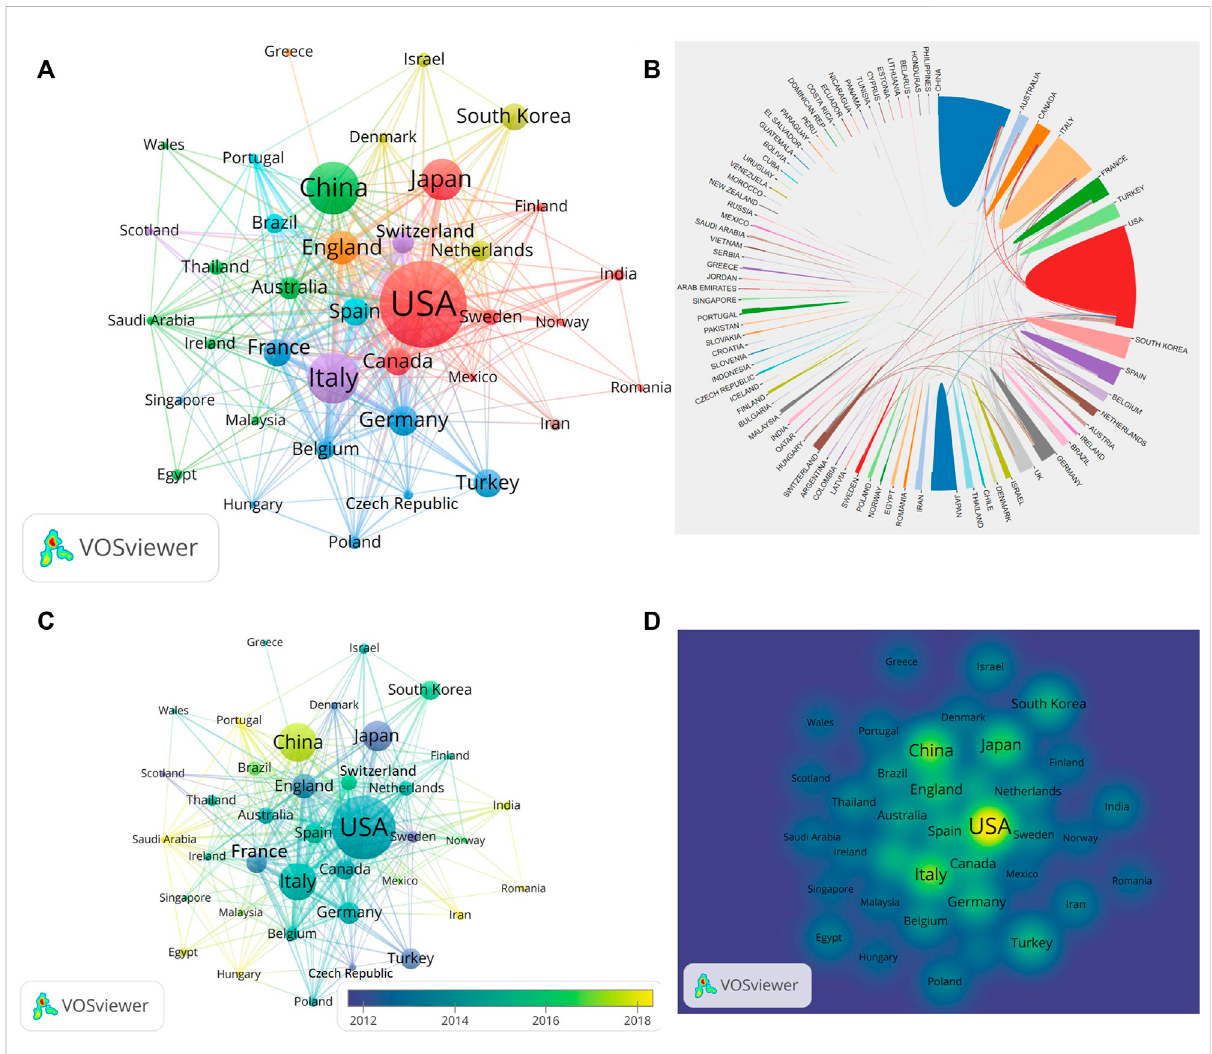
FIGURE 3 Visualization map of countries involved in HA for the treatment of OA research. (A) Collaboration between coutries based on VOSviewer. (B) Collaboration between coutries based on Online Analysis Platform of Literature Metrology. (C) Dynamics and trends of coutries over time. (D) Density map of country distribution of published articles based on